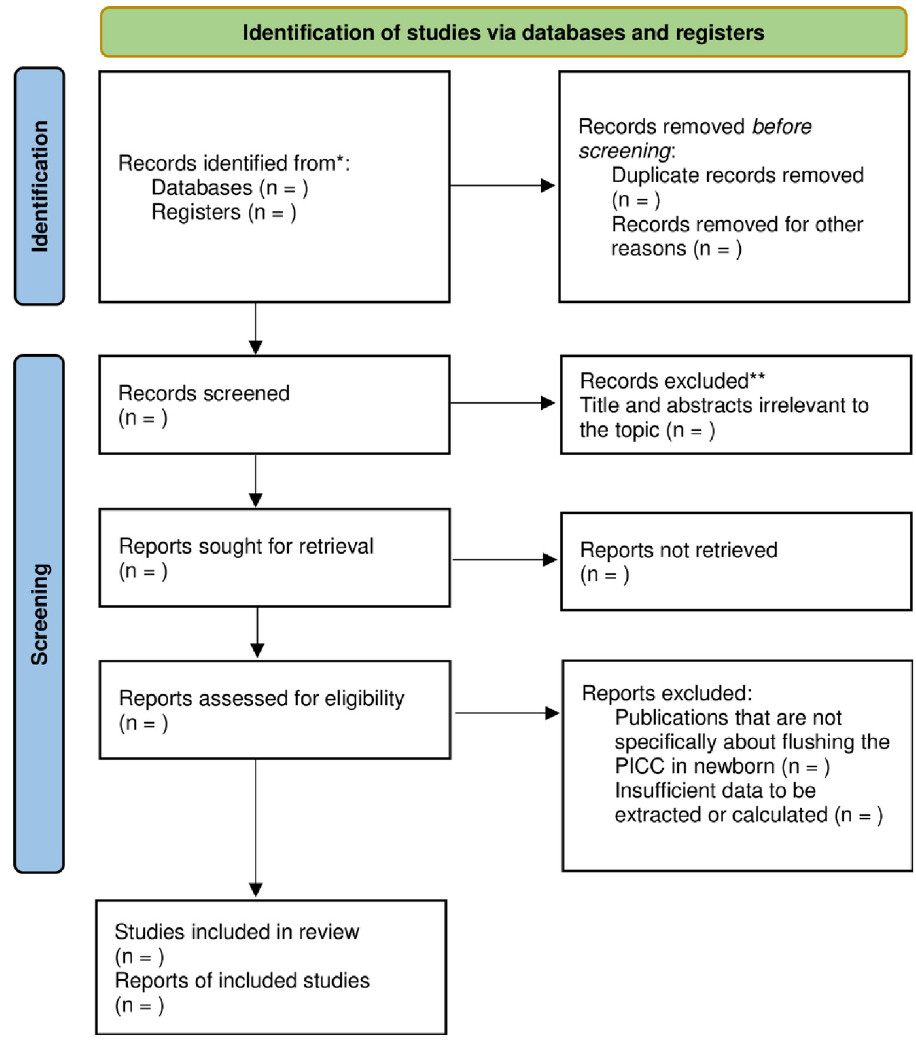
Fig 1. PRISMA flow diagram for systematic review and